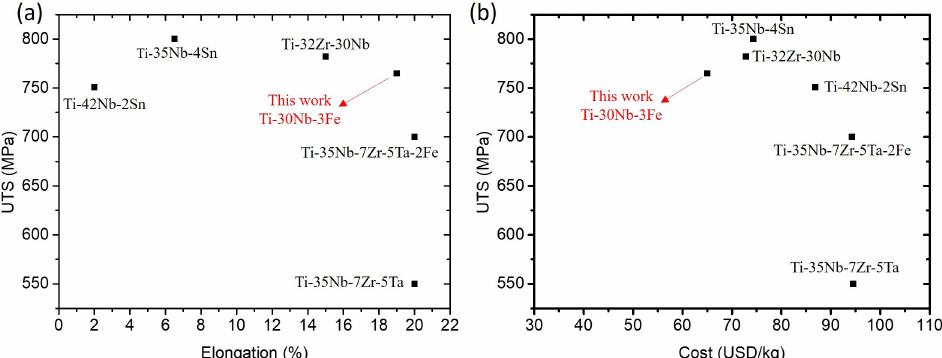
Figure 10. UTS vs. Elongation and UTS vs. costs of biomedical alloys described in the literature compared to those obtained in this